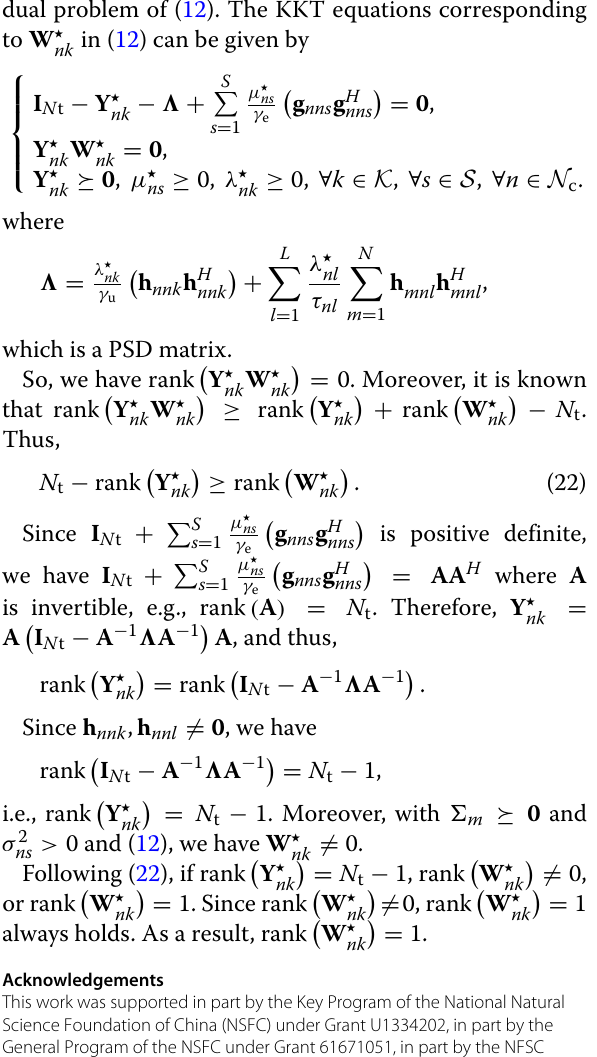
Fig. 7 Comparison of the centralized design and the distributed